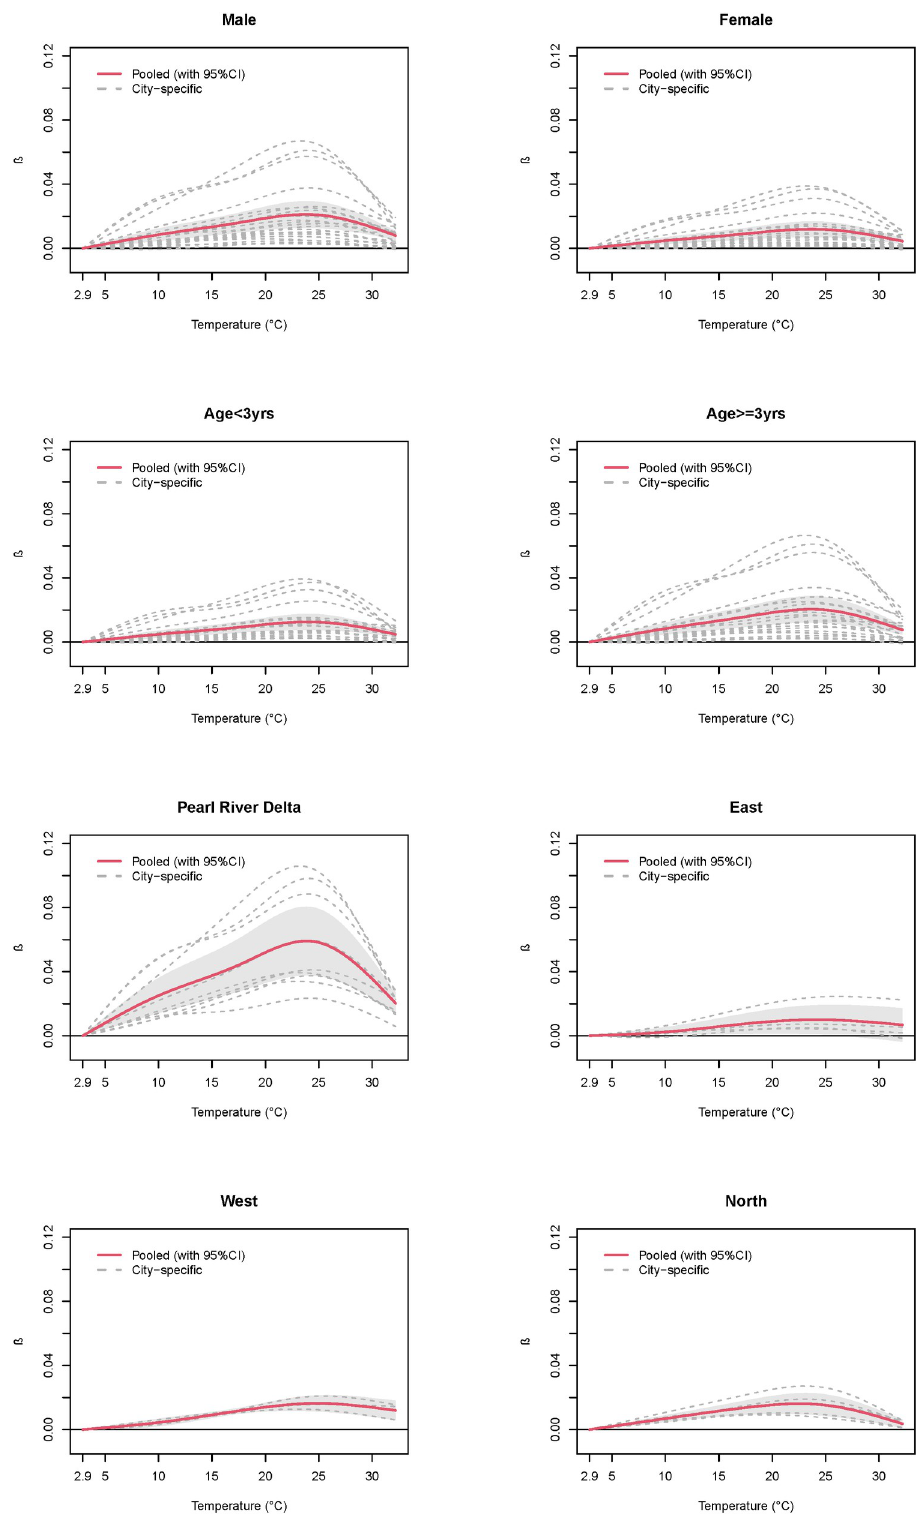
Fig 3. Overall cumulative predicted association of HFMD DALY associated with daily mean temperature by sex, age, and regions. HFMD: Hand, foot, and mouth disease; DALY: Disability adjusted life year. The association was predicted on lag 0–14 days and reference temperature was